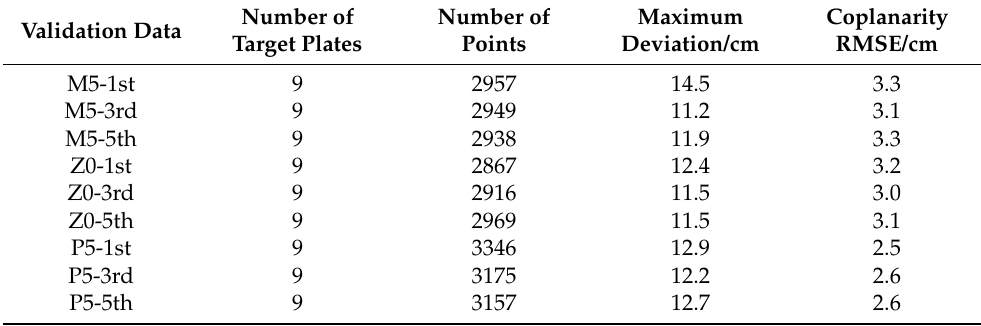
Table 5. Relative coplanar accuracy of cross-calibration at different measurement